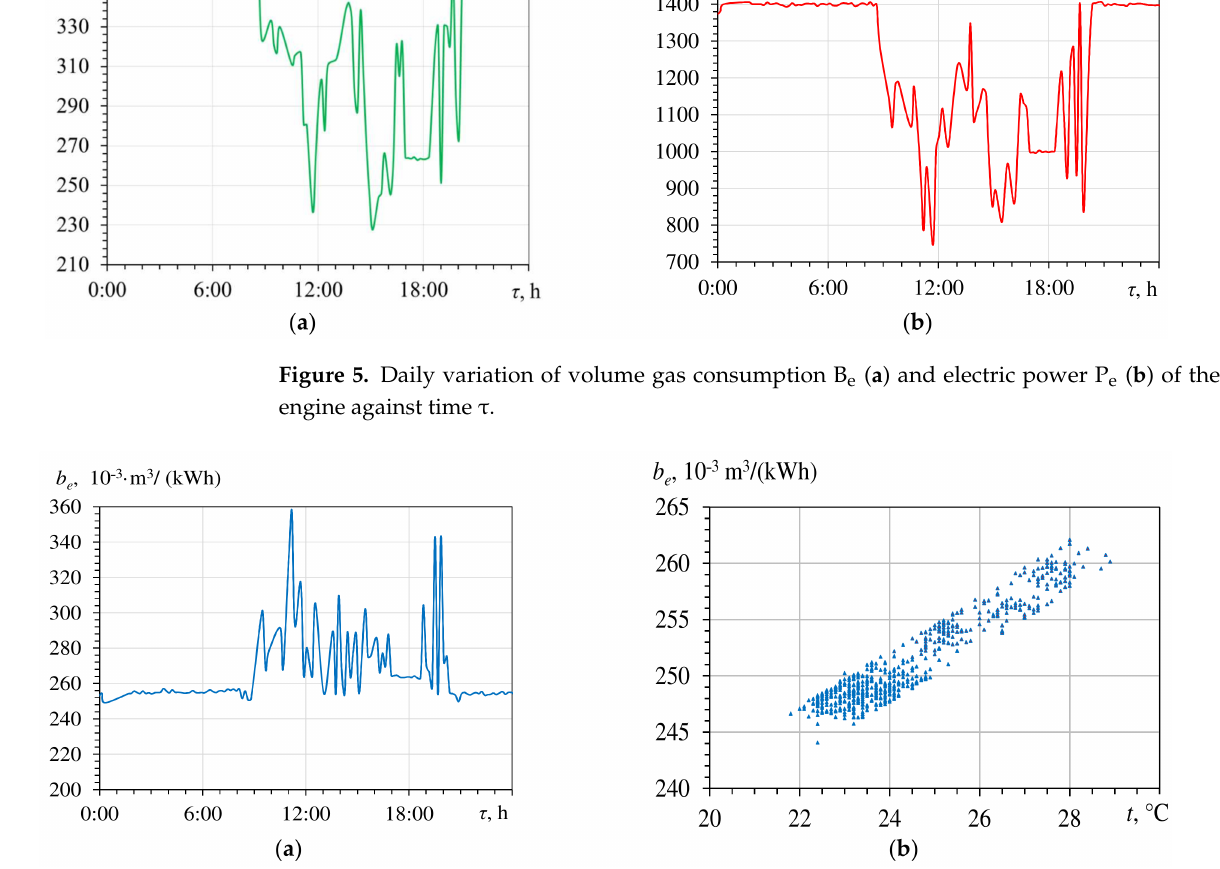
Figure 6. Specific volume gas consumption b e aa a daily variation against time τ ( a ) and inlet air temperature t ( b ).